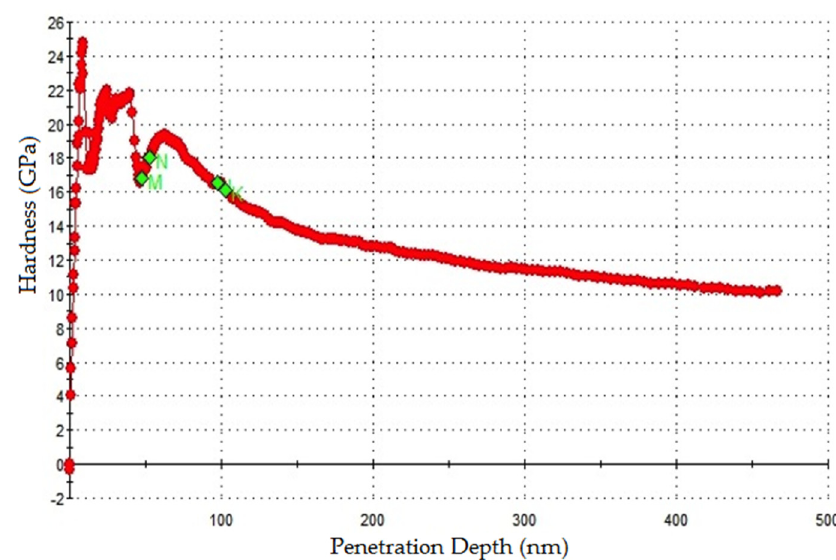
Figure 10. Variation of hardness with the depth of indentation on glass flakes.